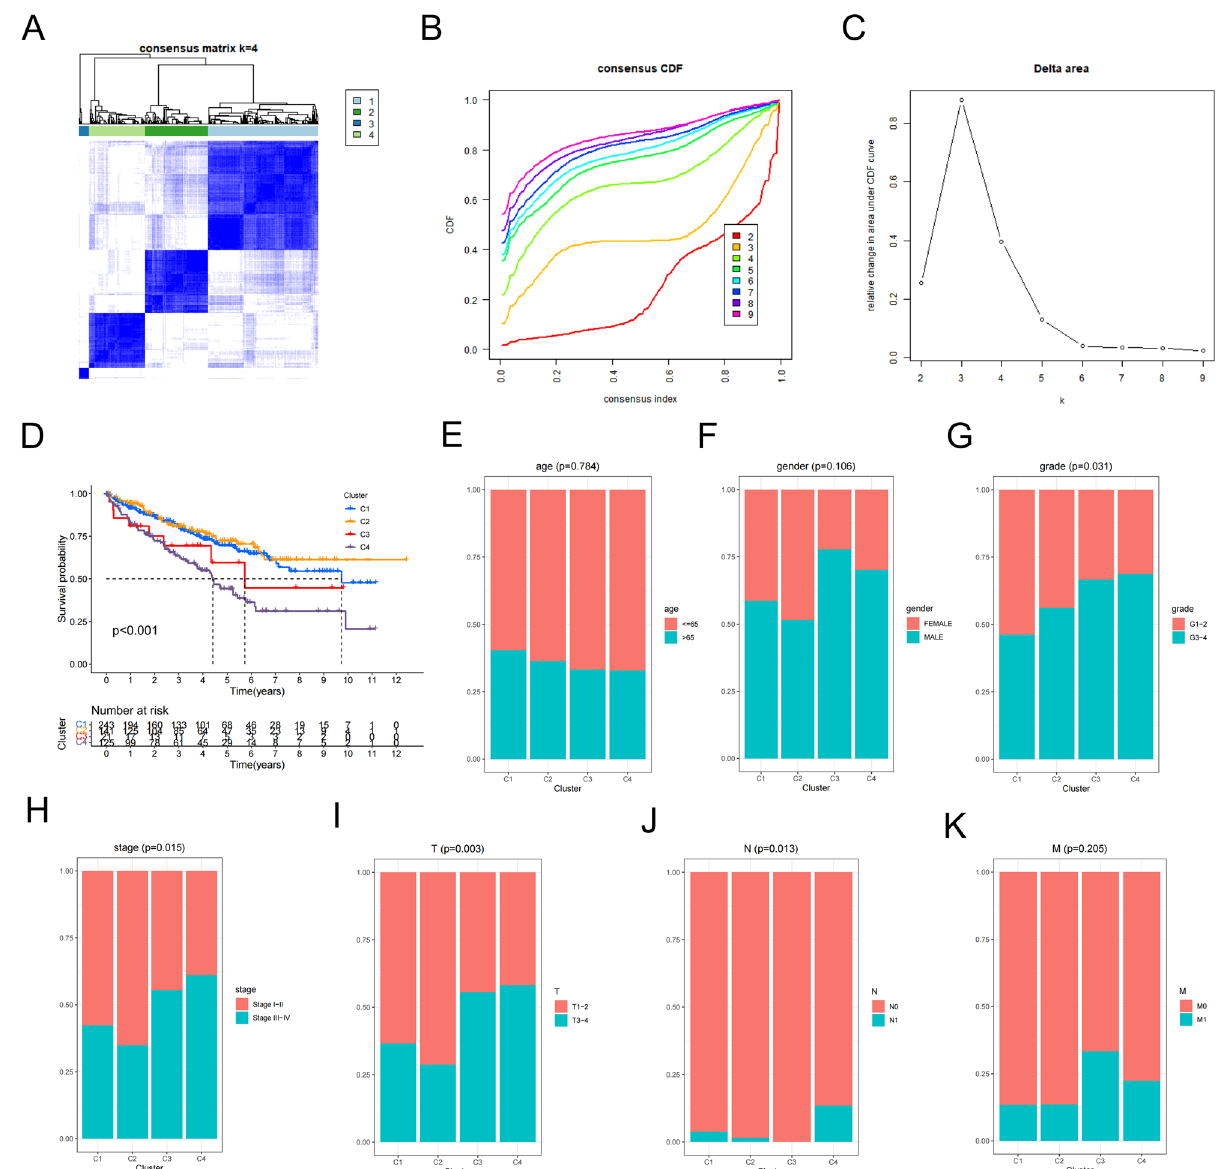
Figure 4. Identification of DRG-based molecular subtypes and clinical analyses. ( A–C ) Four molecular subtypes were identified at a clustering threshold of K max = 9. ( D ) The Kaplan–Meier survival plot for four molecular subtypes (P < 0.001). ( E–K ) Proportions of clinicopathological features (age, gender, grade, stage and TNM) among four molecular subtypes. P < 0.05 was considered statistically significant. The bulk RNA-seq data and clinicopathological data of ccRCC samples were accessed from TCGA data base (https:// portal. gdc. cancer.